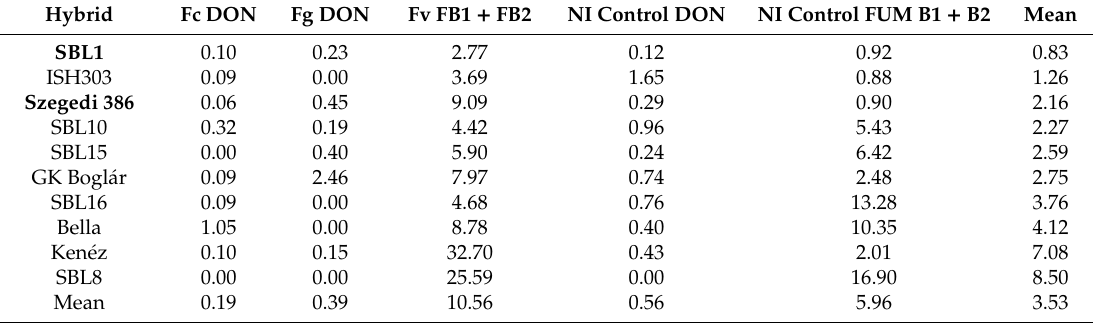
Table 16. Toxin data from the selected set ( n = 10) of hybrids from resistance test to Fusarium spp by silk channel inoculation, mg / kg, 2010–2012,